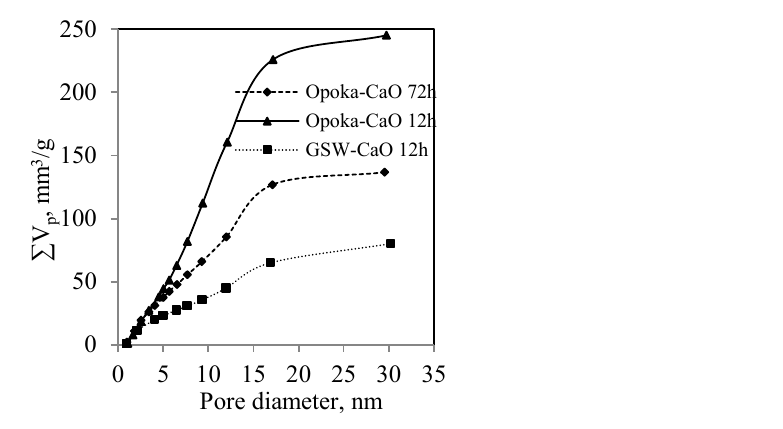
Figure 10. Total pore volume of products (CaO/SiO 2 = 1.0 at 200 °C) after 12 h and 72 h of synthesis.